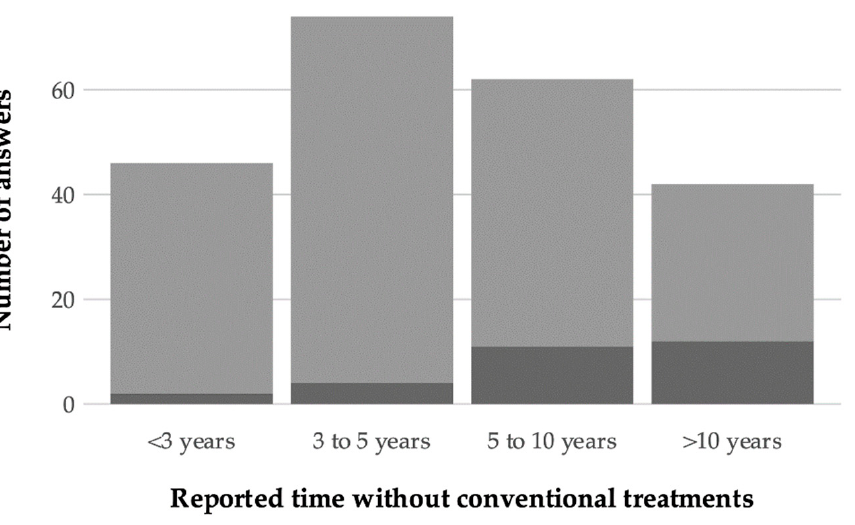
Figure 3. Time span over which the reported managed honey bee, Apis mellifera , colonies were not subjected to treatments against Varroa destructor . The number of answers from the COLOSS survey is shown (dark gray = surviving populations with >30 colonies, N = 29; light gray = groups between five and 30 colonies, N =